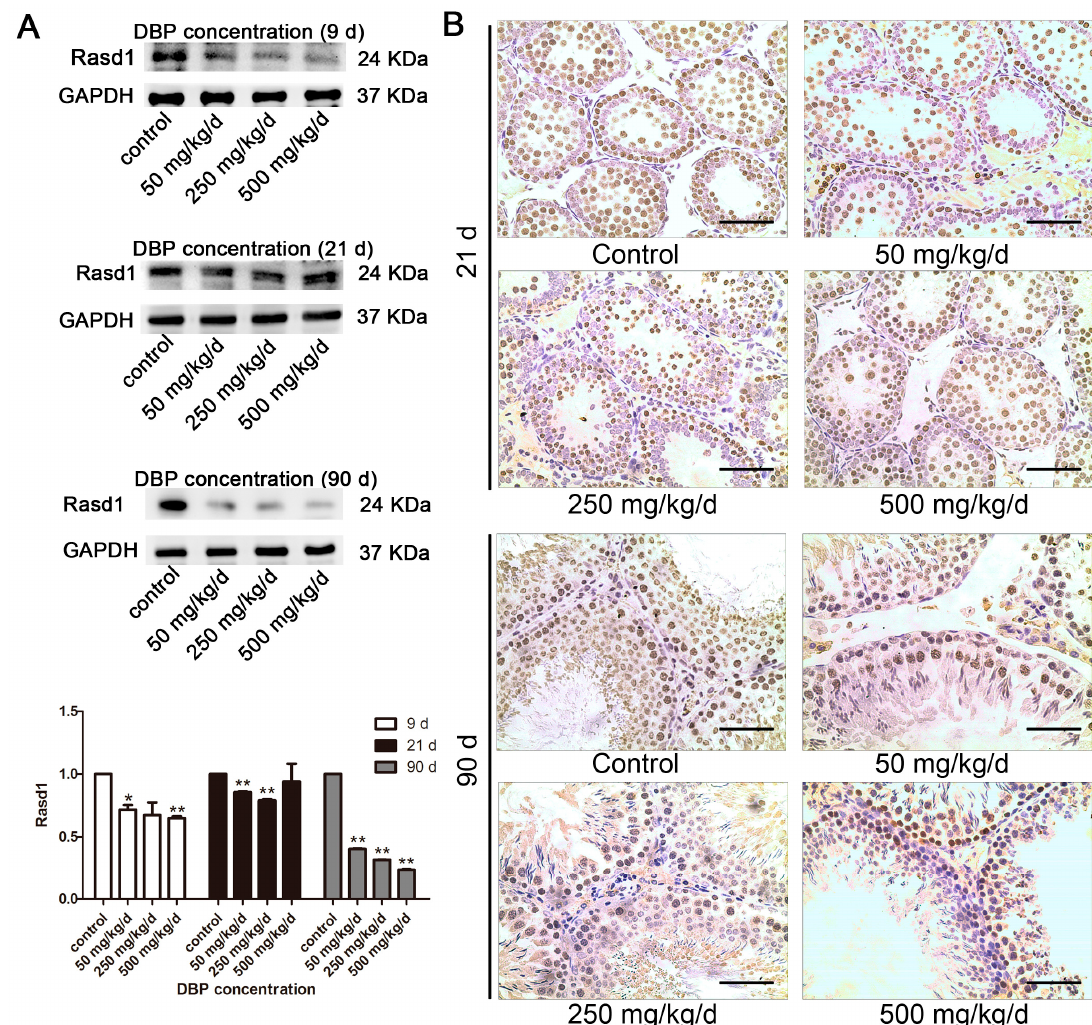
Figure 5. The effects of DBP on Rasd1 analysis: ( A ) The protein level of Rasd1 in testicular tissue treated with various concentrations of DBP were measured by Western blot. The expression of Rasd1 was quantified with ImageJ (lower panel; n = 3). GAPDH was used as a loading control; ( B ) Rasd1 in rat testicular tissue was revealed by immunohistochemistry. Results are expressed as means ± S.D. ** p < 0.01; * p < 0.05. Scale bar = 100 μ m.